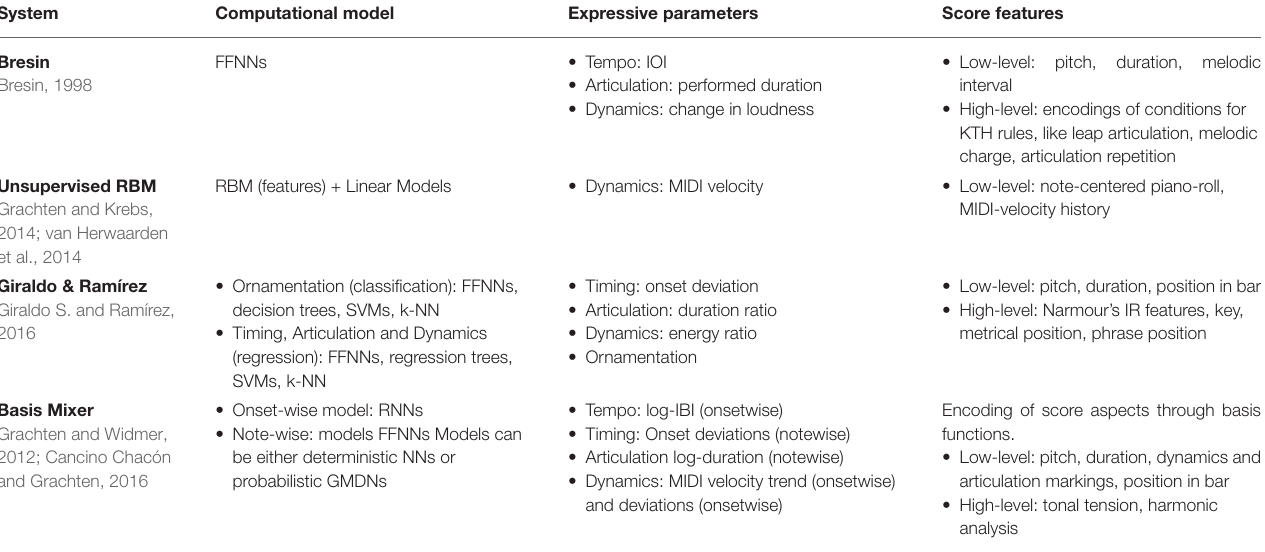
TABLE 2 | Neural network based